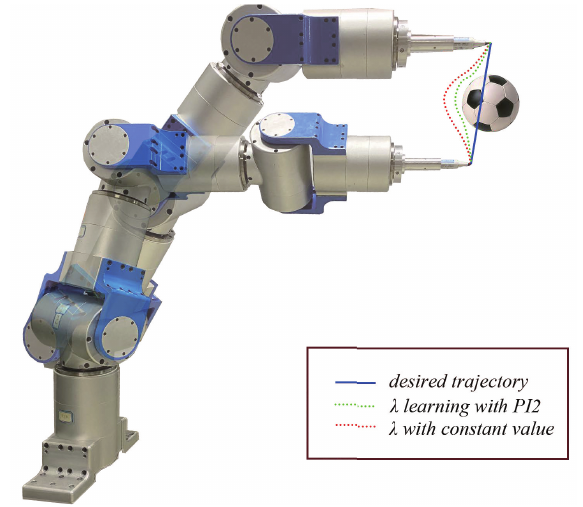
Figure 8. Obstacle avoidance behavior with different values of λ